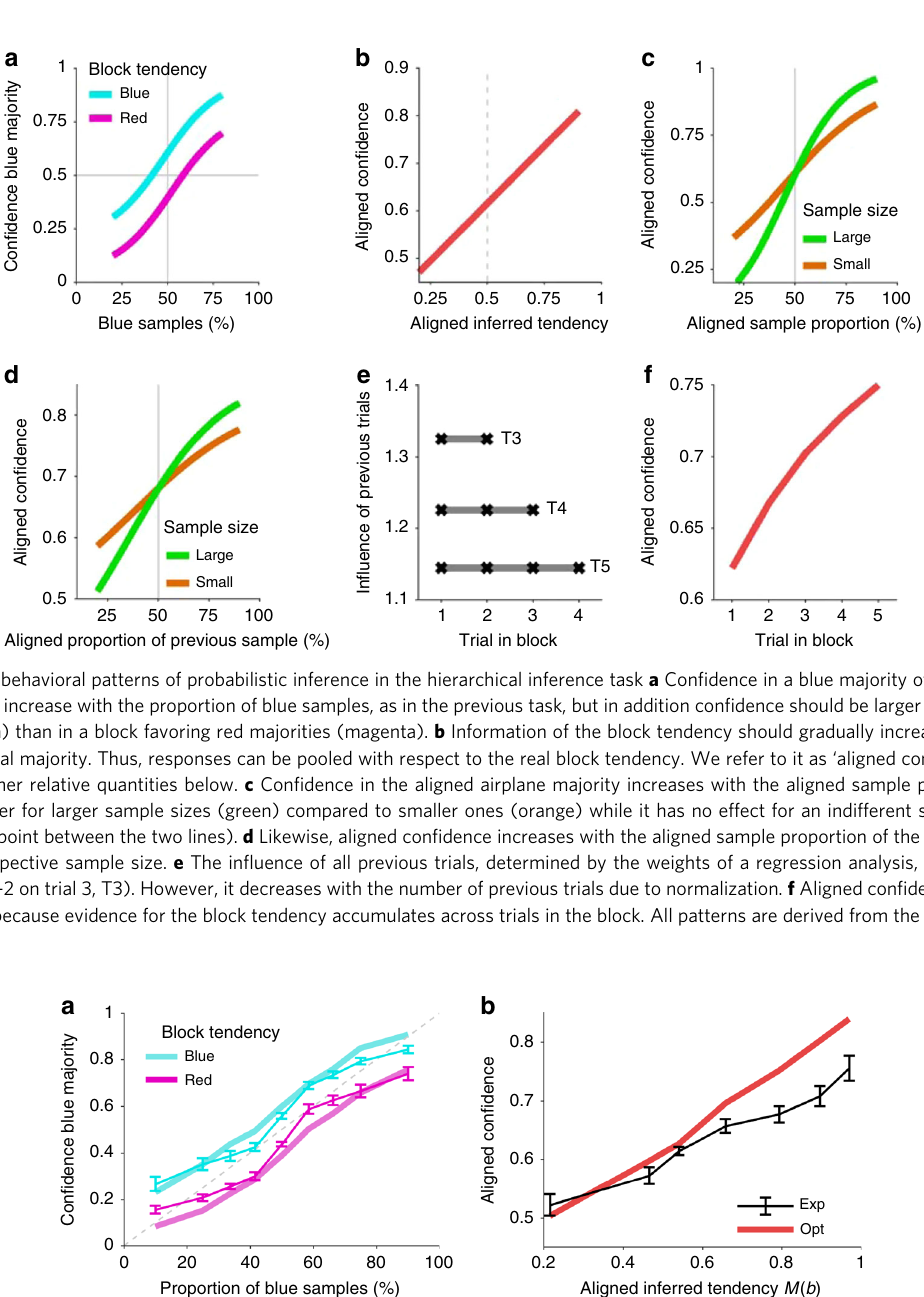
Fig. 5 Inferred block tendency affects con fi dence reports. a Con fi dence in blue majority is higher when the block tendency favors blue majorities (cyan) than when it favors red majorities (magenta). Experimental results (data points) are shown along with optimal behavior (solid lines), indicating an integration of sample information with a learned belief about the block tendency. b Aligned con fi dence (black) increases with the optimally inferred belief about the block tendency and is a close correlate of the optimal response (red), suggesting that participants internally track a graded belief based on previously available evidence. Error bars indicate SEM across